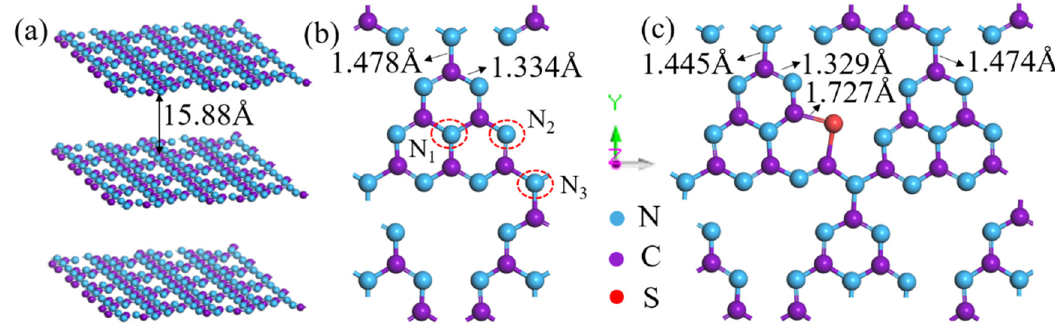
Figure 7: (a) The perspective view, (b) top view of the geometric model of pure g-C 3 N 4 . (c) The top view of S-C 3 N 4